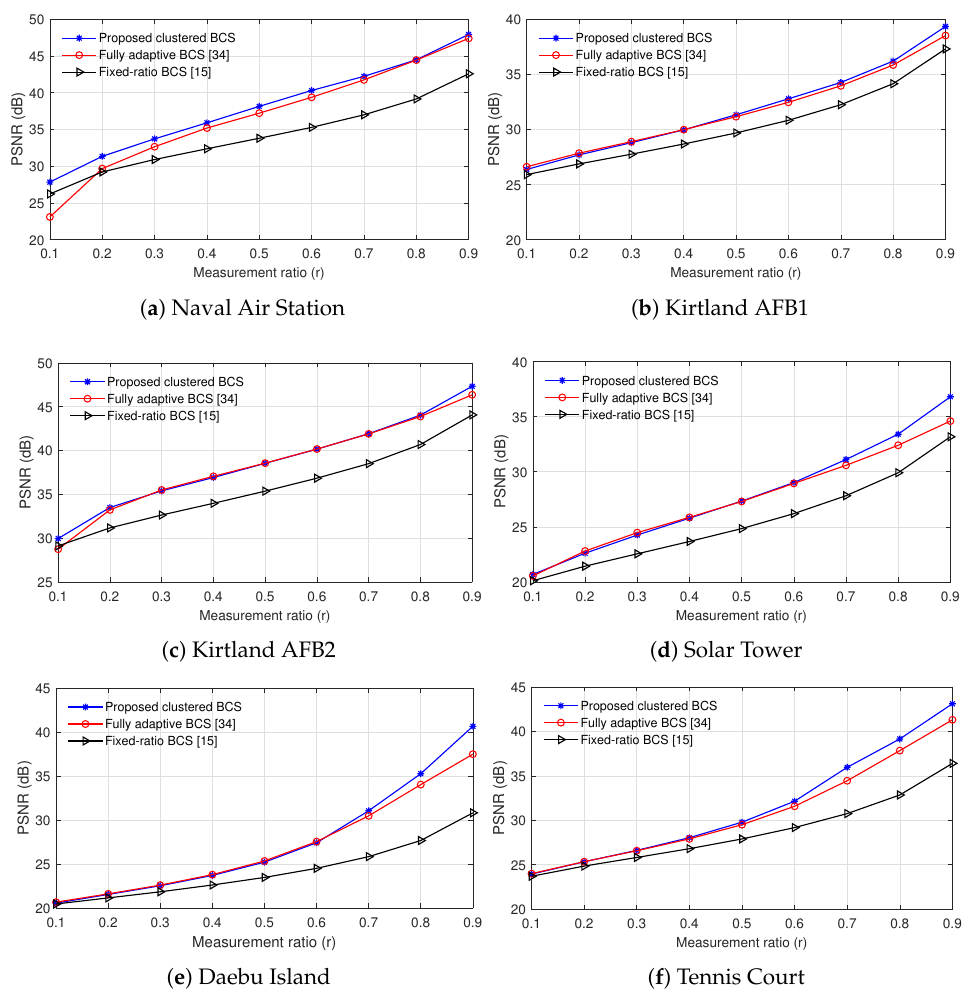
Figure 11. PSNR of various BCS reconstruction methods according to the measurement ratio. Table 3 shows the specific mean and standard deviation values of PSNR corresponding to Figure 11. As mentioned before, PSNR values were obtained by repeating the simulations for more than 20 random realizations of measurement matrices. When r = 0.3, the average PSNR gain of the proposed clustered BCS is in the range of [ 0.68, 2.81 ] dB compared to the fixed-ratio BCS and [ − 0.22, 1.07 ] dB compared to the fully adaptive BCS. When r = 0.5, the average PSNR gain of the proposed method is changed to [ 1.65, 4.34 ] dB compared to the fixed-ratio BCS and [ − 0.13, 0.93 ] over the fully adaptive BCS. When r = 0.7, the average PSNR gain is in the range of [ 2.02, 5.24 ] dB and [ − 0.01, 1.51 ] dB compared to the